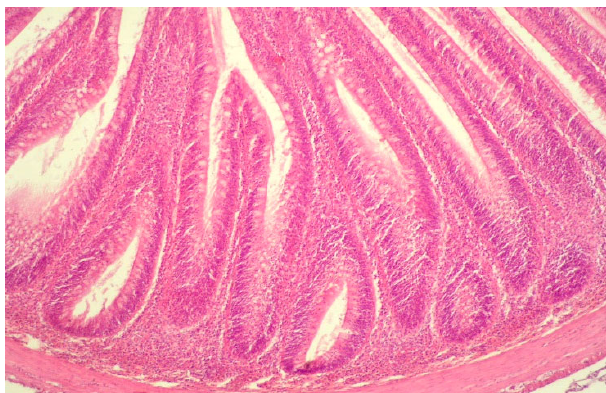
Fig. 6. Crypts of carp intestinal mucosa in Experiment 2. H&E. x 100